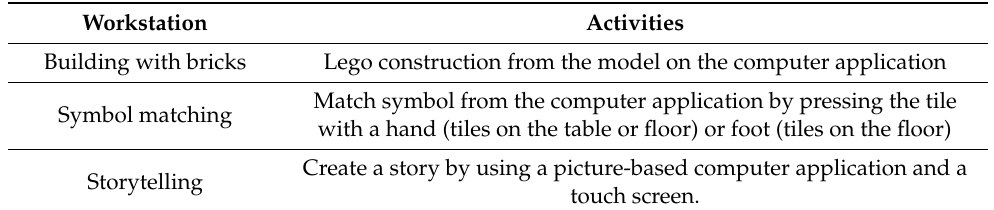
Table 6. The activities in the workstations